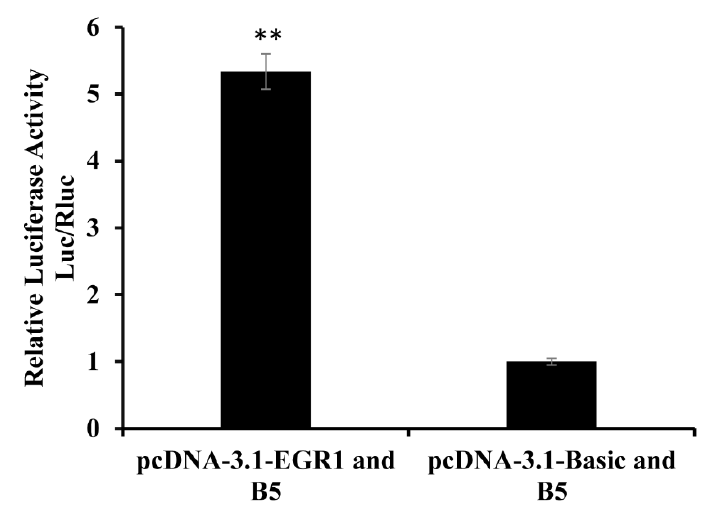
Figure 6. Relative activity analysis of EGR1 . Note that for pcDNA-3.1- EGR1 and B5, the EGR1 overexpression vector was co-transfected with the B5 fragment; for pcDNA-3.1-Basic and B5, the pcDNA-3.1 vector was co-transfected with the B5 fragment. The group of pcDNA-3.1-Basic and B5 was the control group. The marker “**” represents a highly significant difference ( p < 0.01).